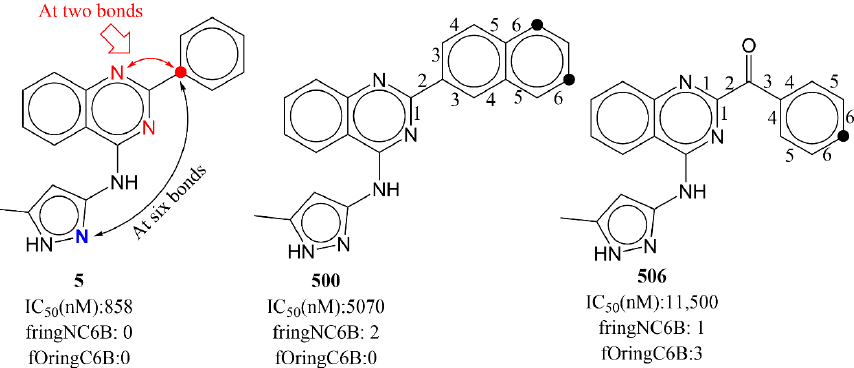
Figure 11. Depiction of fringNC6B using molecule numbers 5, 500, and 506 as representative examples. The carbon present at six bonds from ring nitrogen has been depicted using black dots. The numbers (black) indicate the counting of number of bonds between ring nitrogen and carbon.